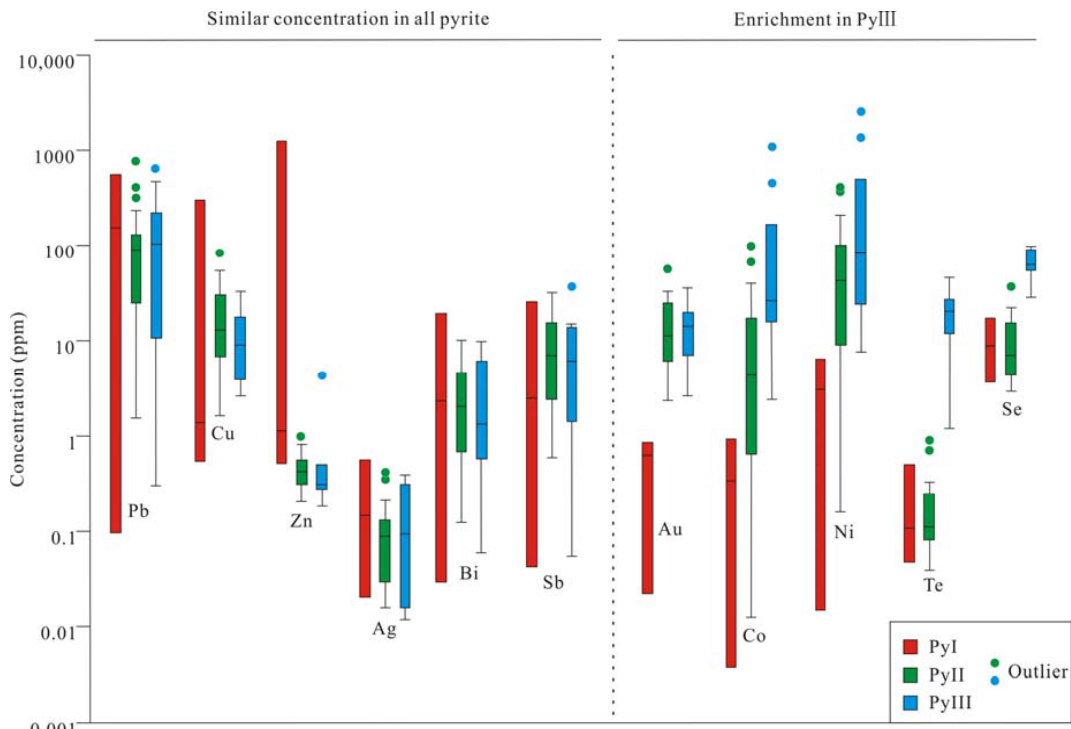
Figure 11. Comparative box plot of the LA-ICP-MS data of three generations of pyrite, illustrating the concentration ranges of specific trace elements and highlighting significant relative enrichments. The red box indicate PyI, the green box present PyII, and the blue box shows PyIII. The outlier present the anomalous data, error bars represent SD.